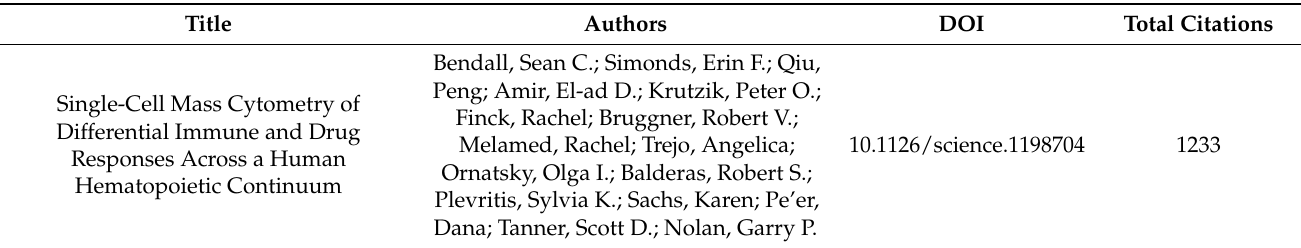
Table A1. H-Classics collection in mass cytometry (71